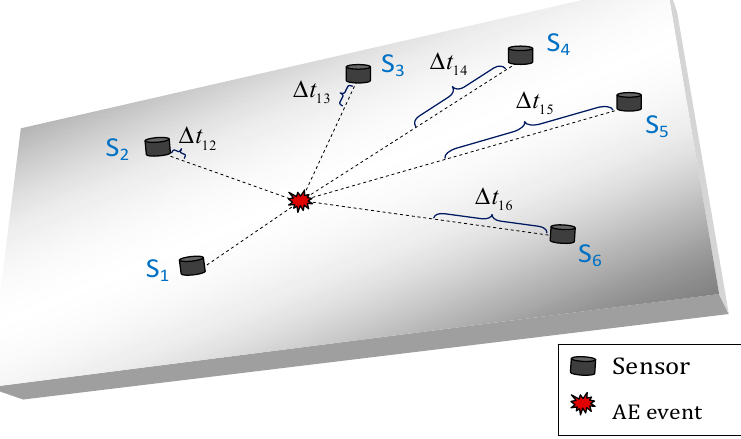
Figure 3. Two-dimensional localization principle of AE source .